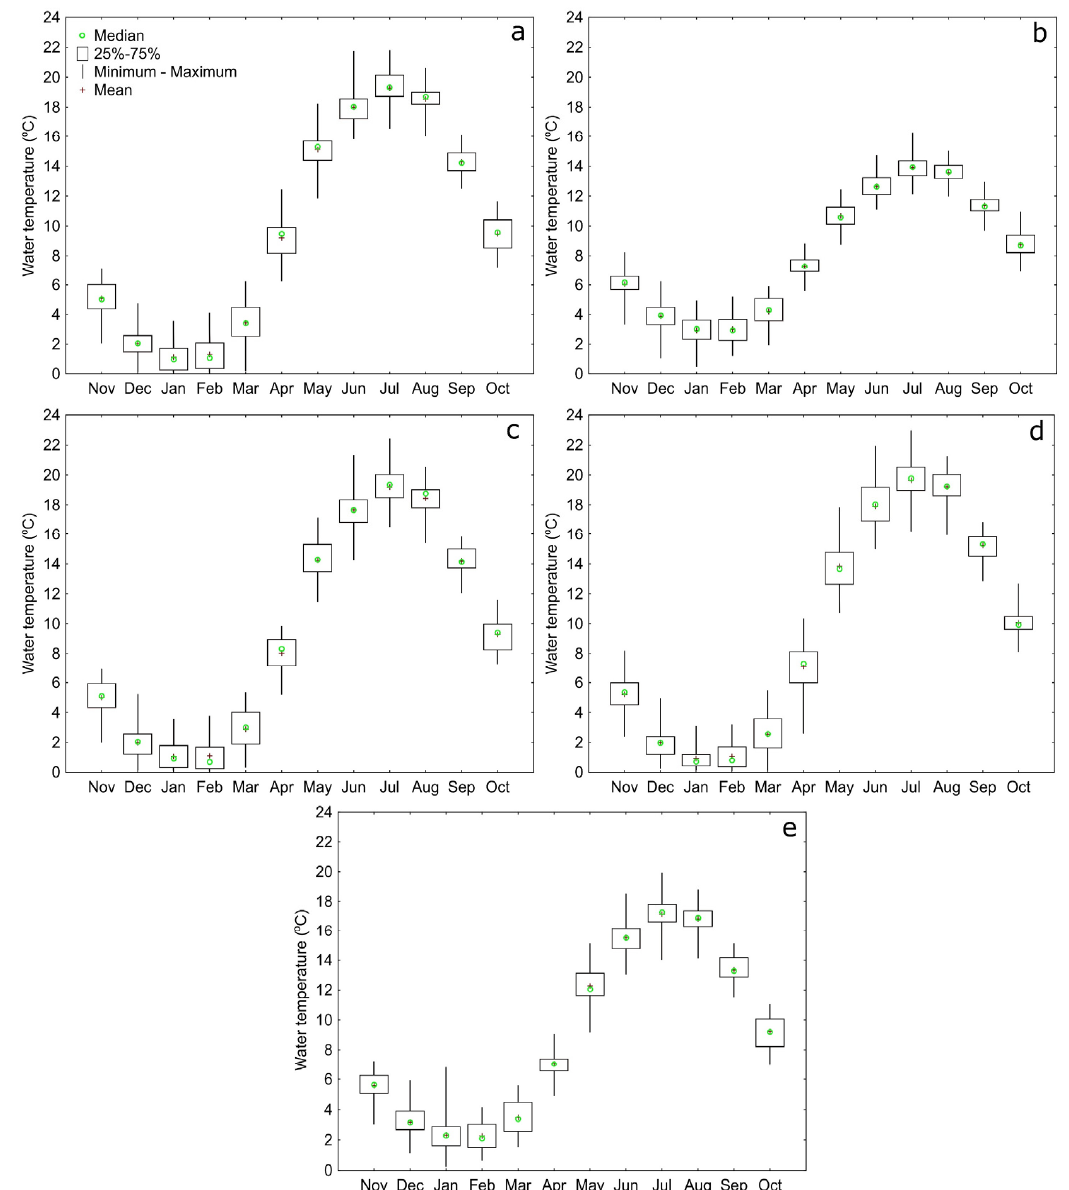
Figure 3. Changes in mean monthly temperatures in the years 1987–2020 in rivers: Drw˛eca ( a ); Łeba ( b ); Ł yna ( c ); Pisa ( d ) and Wda ( e ).